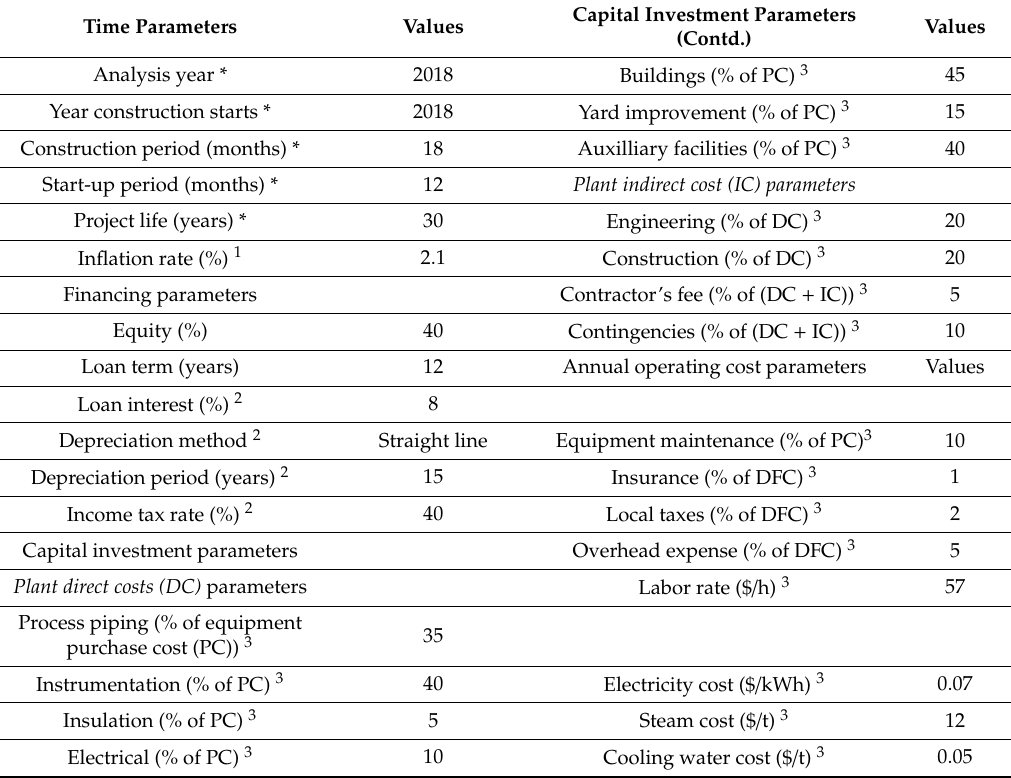
Table 2. Economic parameters for the lactic acid production process using corn